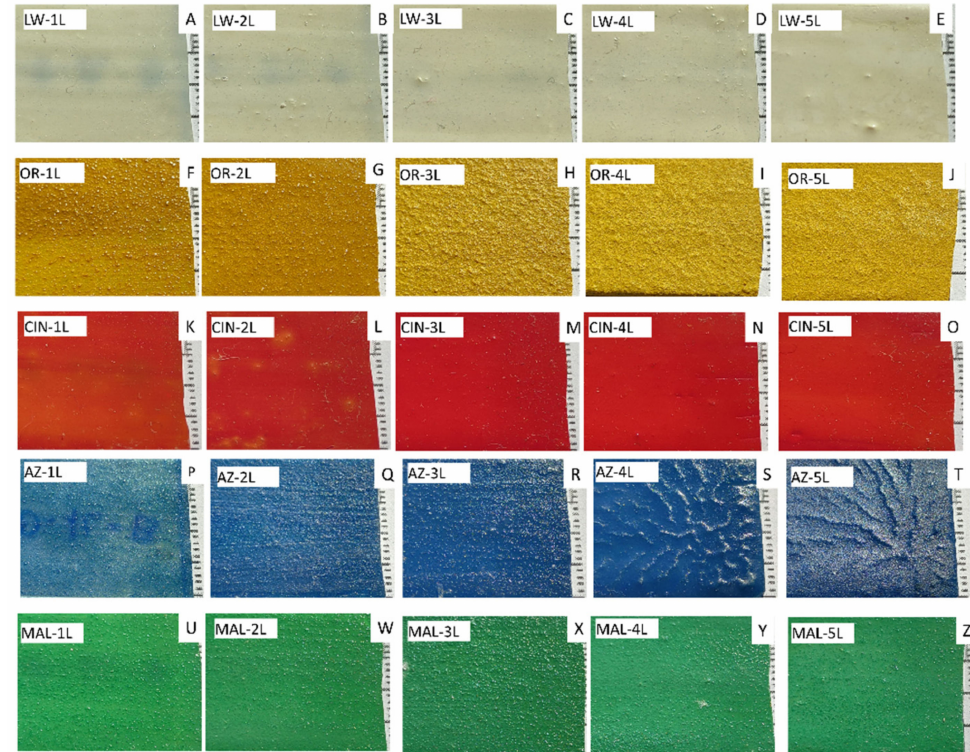
Figure 3. Digital photographs of the painting mock-ups used to determine the influence of the painting layer thickness (one layer to five layers, 1L to 5L) on the spectral reflectance. ( A – E ): lead white (LW)-based oil painting mock-ups. ( F – J ): orpiment (OR)-based oil painting mock-ups. ( K – O ): cinnabar (CIN)-based oil painting mock-ups. ( P – T ): azurite (AZ)-based oil painting mock-ups. ( U – Z ): malachite (MAL)-based oil painting